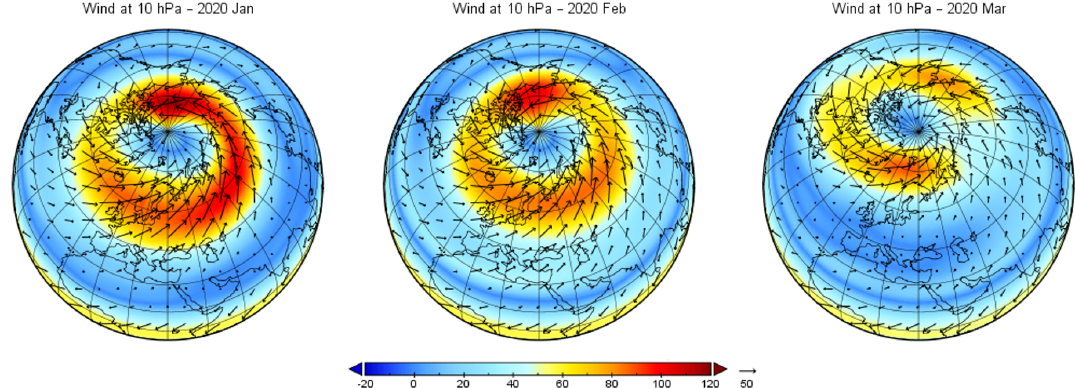
Figure 4. ERA5 monthly mean wind at 10hPa (about 30km altitude), showing a strong vortex in the north polar region, with speeds of up to 118, 103, and 89ms − 1 for January to March 2020 respectively.